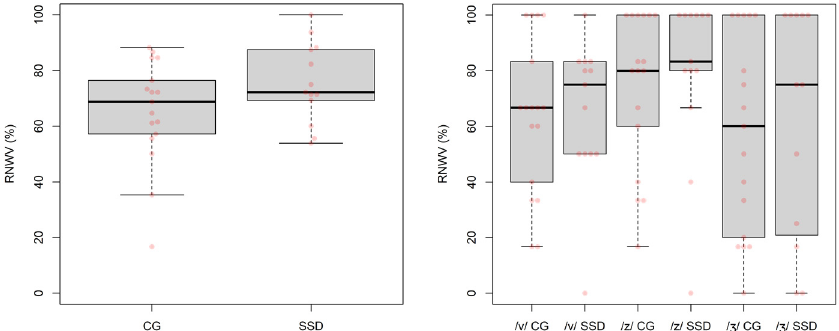
(ARSS: slope = − 0.49, SE = 0.37, p = 0.197; ARLS: slope = − 0.55, SE = 0.215, p = 0.215).